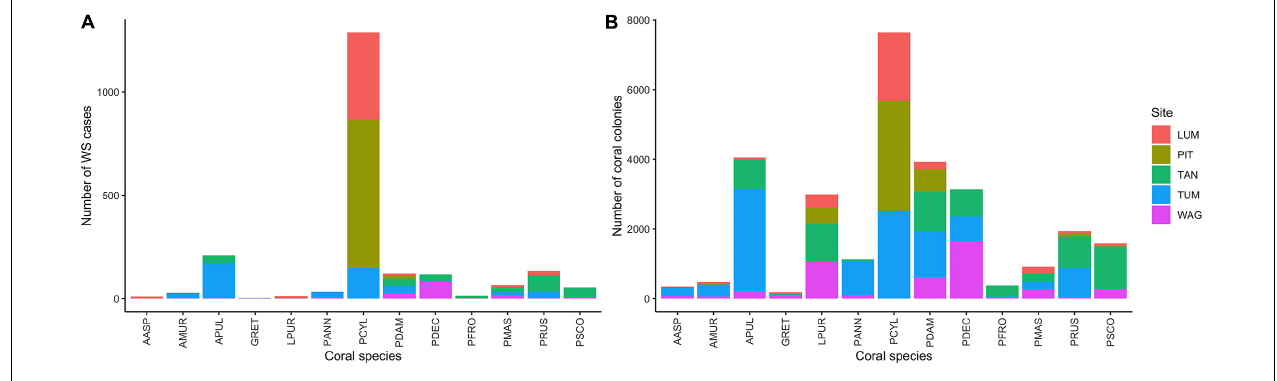
FIGURE 2 | (A) Number of White Syndrome (WS) cases and (B) total counts of coral colonies per species and site in the full consensus